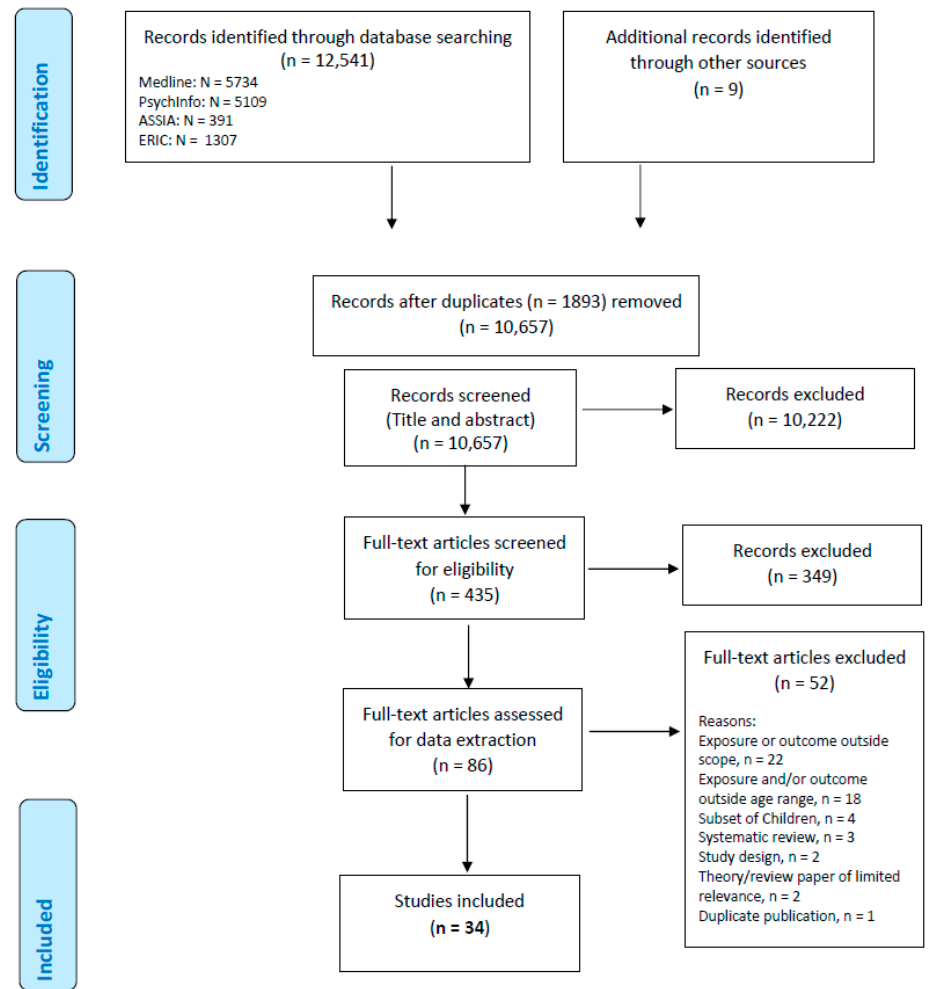
Figure 1. PRISMA flowchart of study selection process.